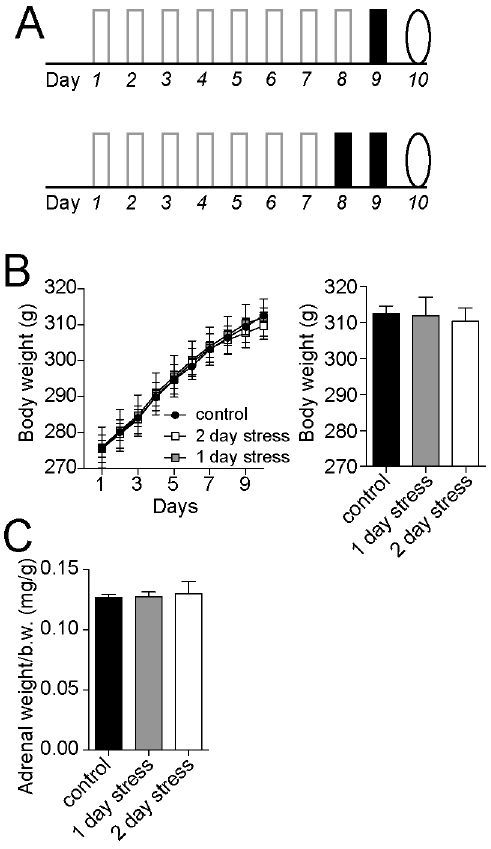
Figure 3. One or two day stress does not have significant effects. A) To control for effects due to a single stress or two days of stress, and not due to the cumulative effects of stress, the effects of one (top) or two days (bottom) of stress was examined. Solid bars indicate the day of stress, open bars indicate days of no stress, oval indicates the test day. B) Neither one nor two days of stress had any significant effects on body weight over the course of the experiment, nor on body weight one day after the final stress, compared to control handling. C) Neither one nor two days of stress had any significant effects on adrenal gland